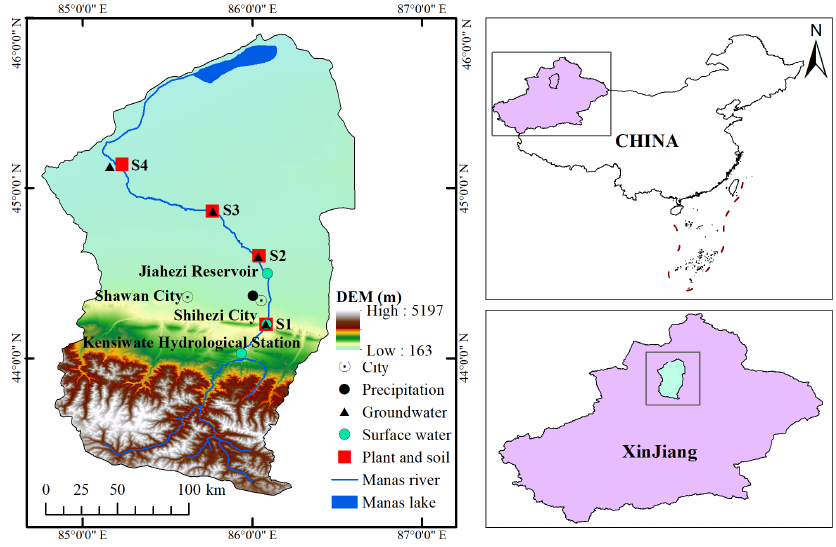
Figure 1. Locations of the sampling sites in the Manas River Basin.